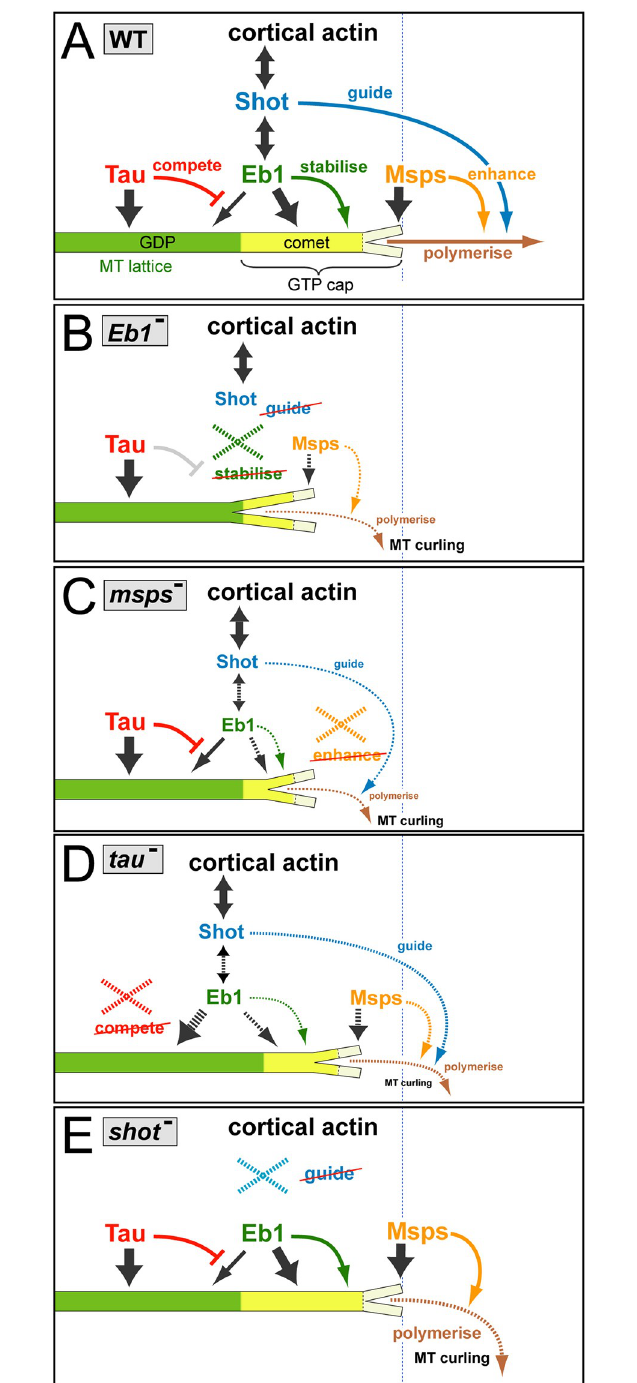
Fig 7. A mechanistic model consistent with all reported data. A ) In wild-type (WT) neurons, the three factors bind (dark grey arrows) to MTs at different locations: Msps binds to the very tip of MT plus-ends, Eb1 forms plus-end comets (bright yellow) by binding with higher affinity to GTP-tubulin (GTP-cap, curly bracket) but lagging behind the front, and Tau localises along the MT lattice primarily composed of GDP-tubulin (green). Tau outcompetes (red T- bar) low-affinity binding of Eb1 along the lattice, thus maintaining more Eb1 at MT plus-ends. Msps enhances (orange arrow) MT polymerisation (brown), thus sustaining a prominent GTP-cap that Eb1 can bind to. Eb1 stabilises MT plus-ends (green arrow) by promoting sheet formation of protofilaments at the plus-end (short Y-shaped tip), thus improving conditions for Msps binding. Eb1 also recruits the C-terminus of Shot which binds cortical actin via its